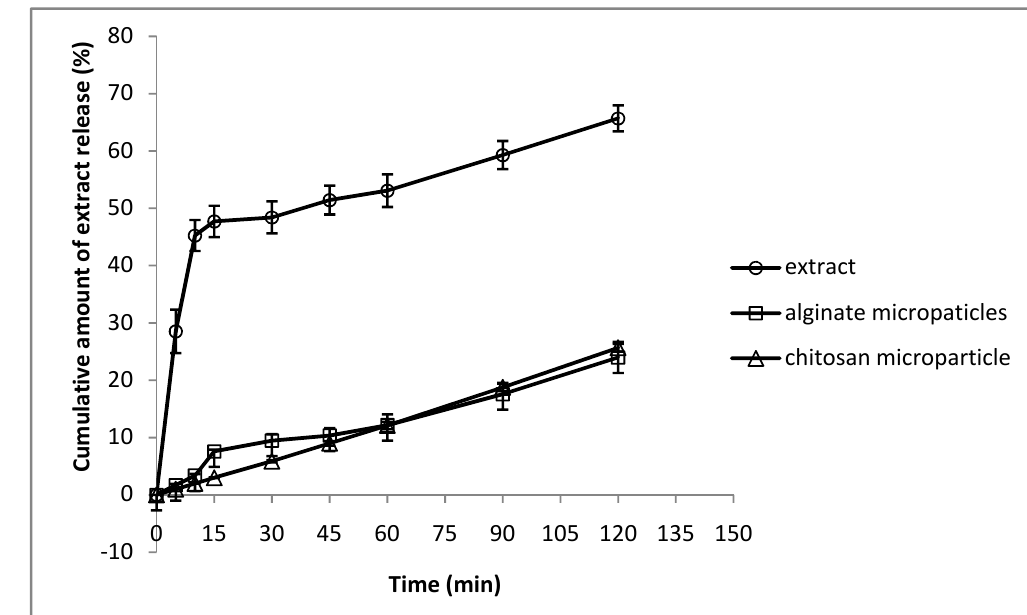
Figure 4. In vitro release behavior of extract (powder), extract from alginate microparticles and extract from chitosan